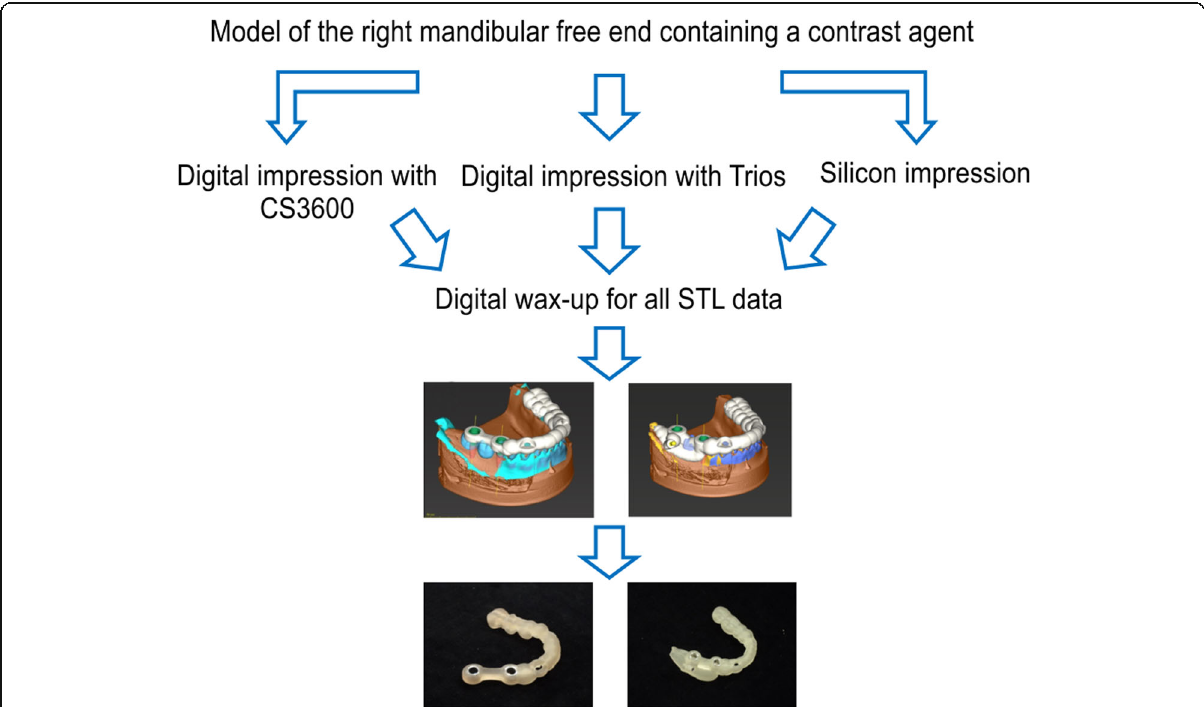
Fig. 1 Flow chart of the fabrication of surgical guide plates. Tooth-supported surgical guide plate and tooth/mucosa-supported surgical guide plate